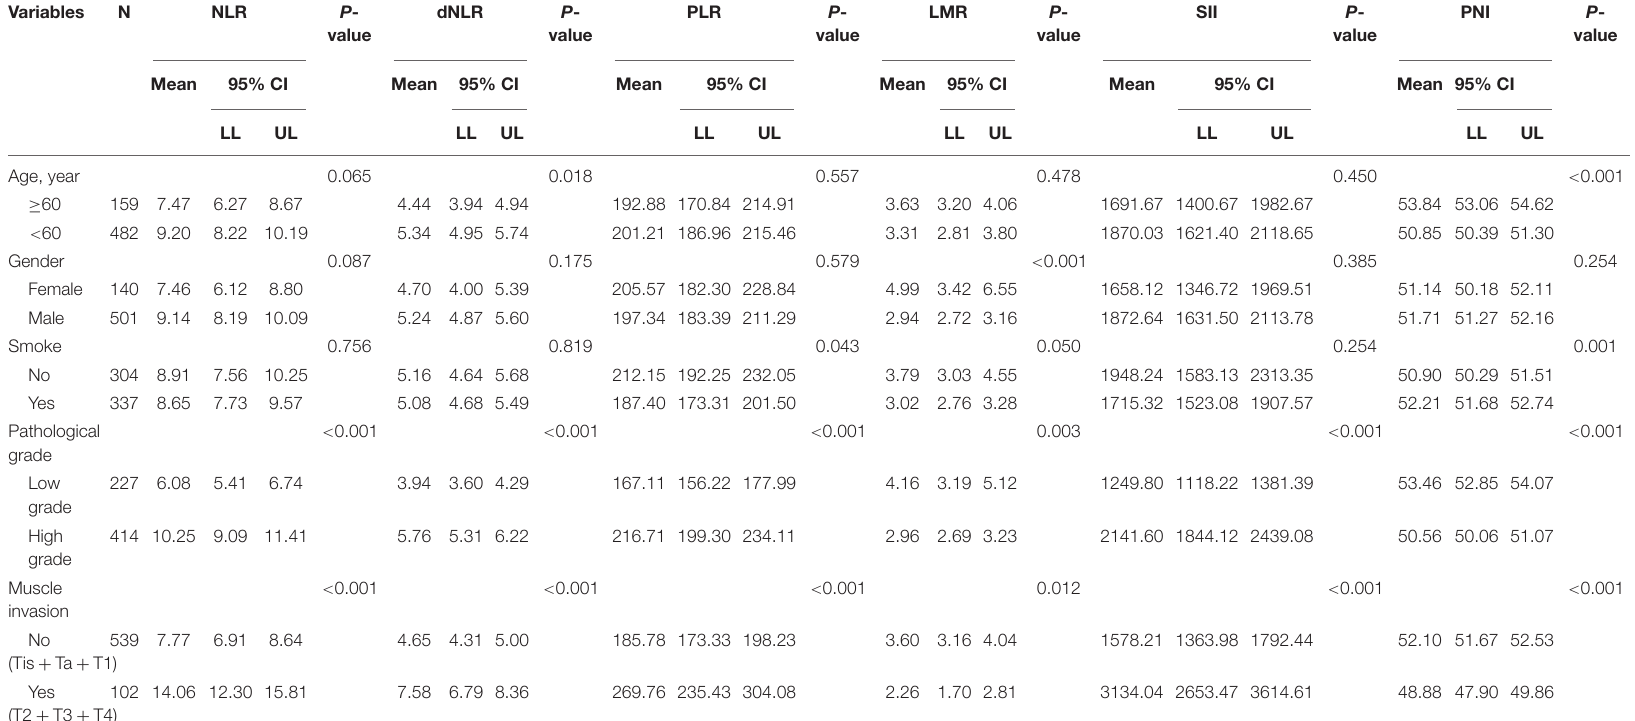
TABLE 2 | Comparison of the values of inflammatory factors between different groups. Variables